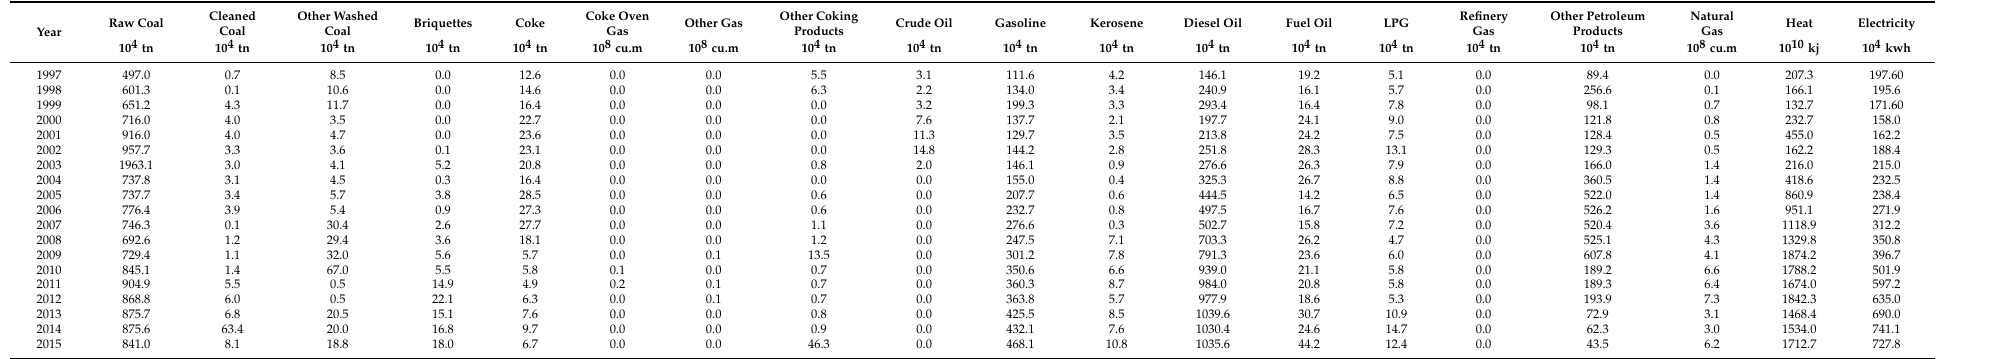
Table 4. National construction industry’s energy and fossil fuel consumption (Shan et al., 2018).